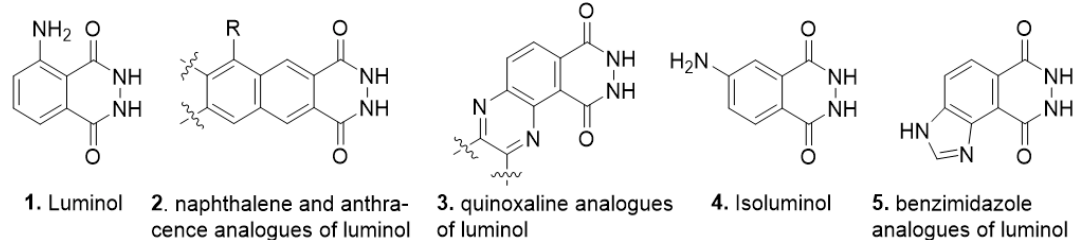
Figure 1. Luminol 1 , naphthalene and anthracene 2 , quinoxaline analogues of luminol 3 , isoluminol 4 , and benzimidazole analogues of luminol 5 .